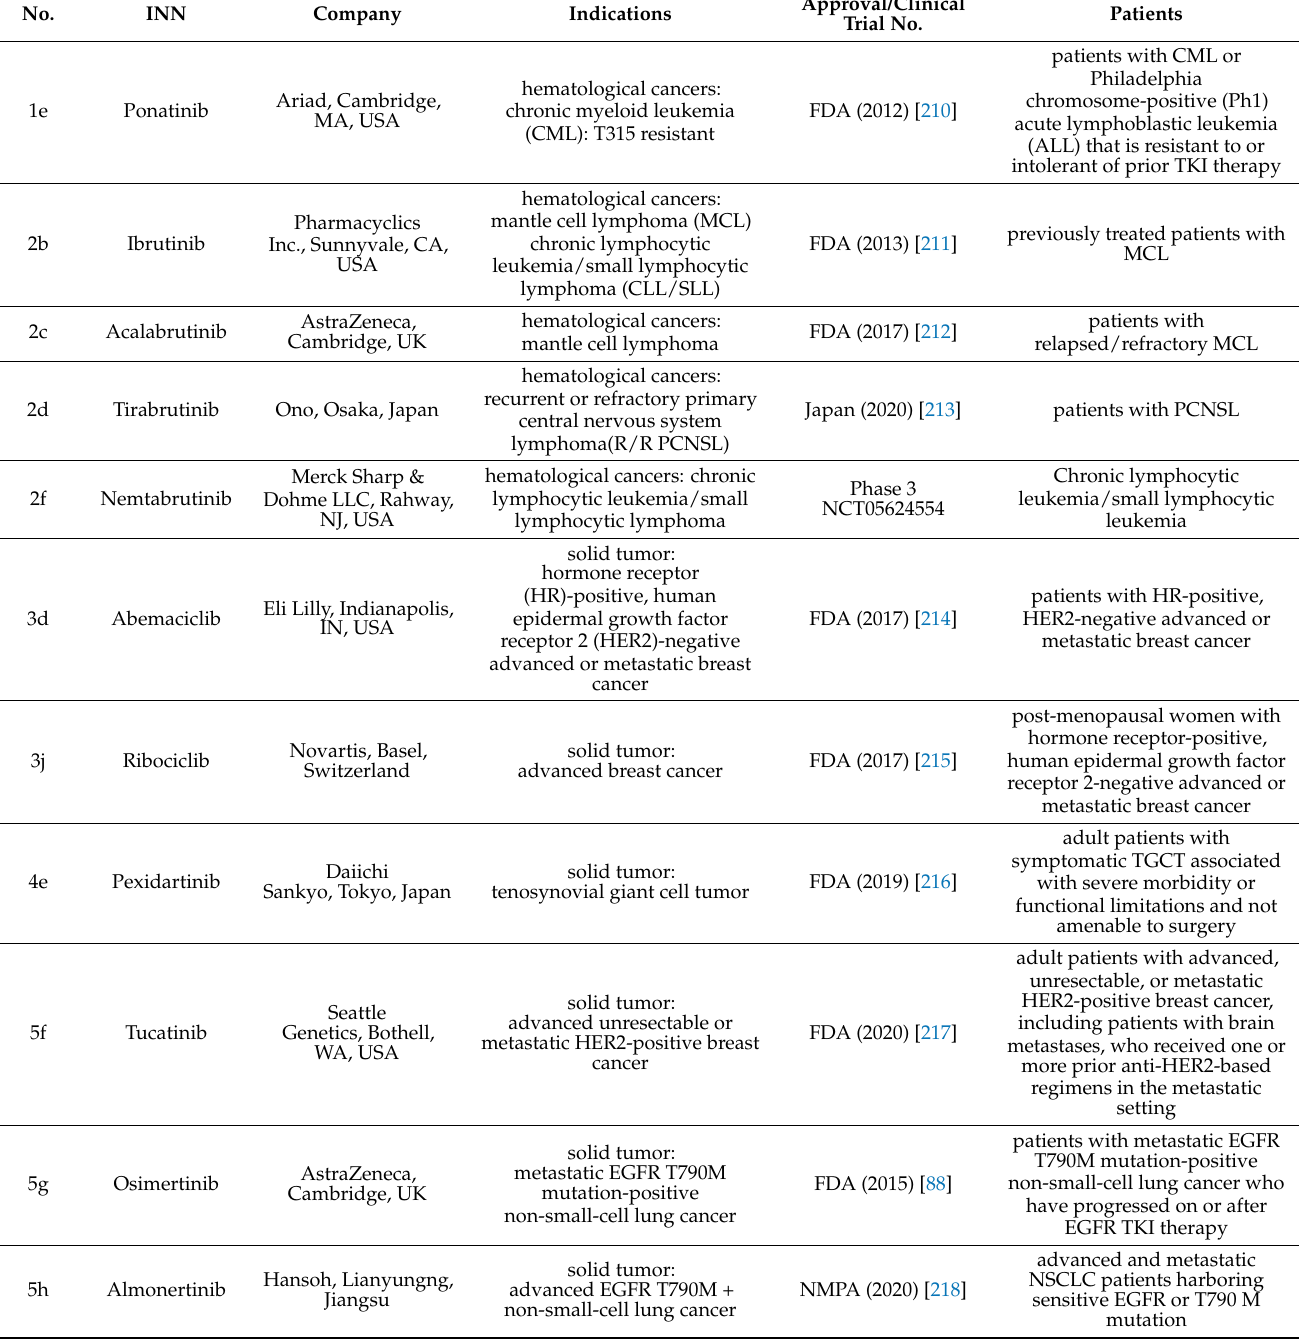
Table 1. Indole/azaindole/oxindole-containing ATP-competitive kinase inhibitors in clinical